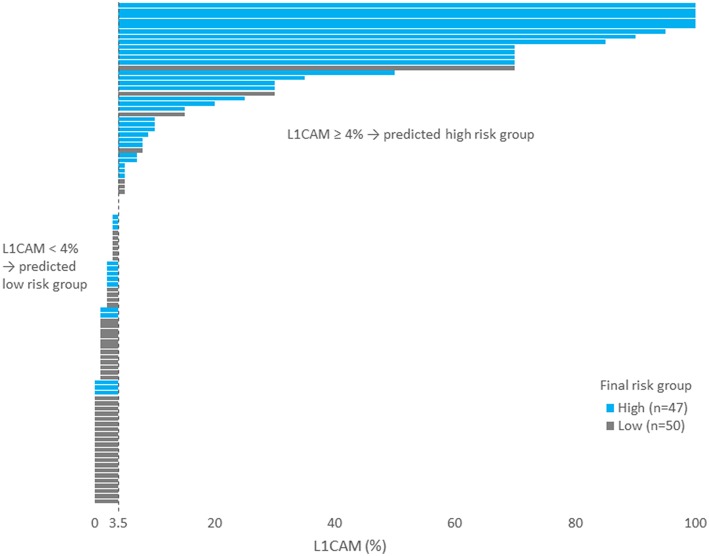
Each patient is represented by one bar. Patients on the left part of the figure (i.e., with L1CAM<4) was predicted as low risk. Blue bars represent wrongly predicted patients here. On the contrary, gray bars on the right side of the figure represent patients wrongly predicted as high risk.